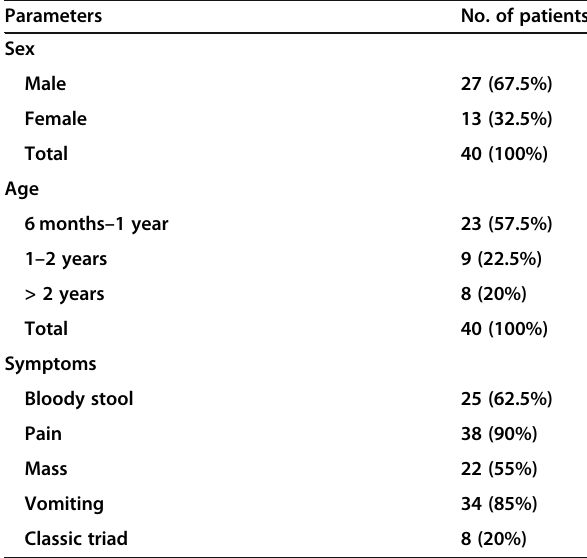
Table 1 Incidence of intussusception according to sex, age, and